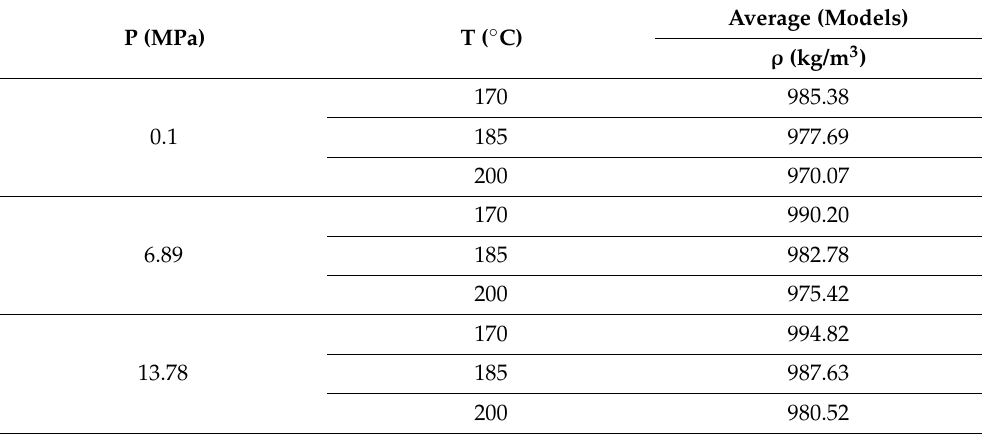
Table 10. Densities of PS calculated at different temperatures and pressures by using Equations (15–17).